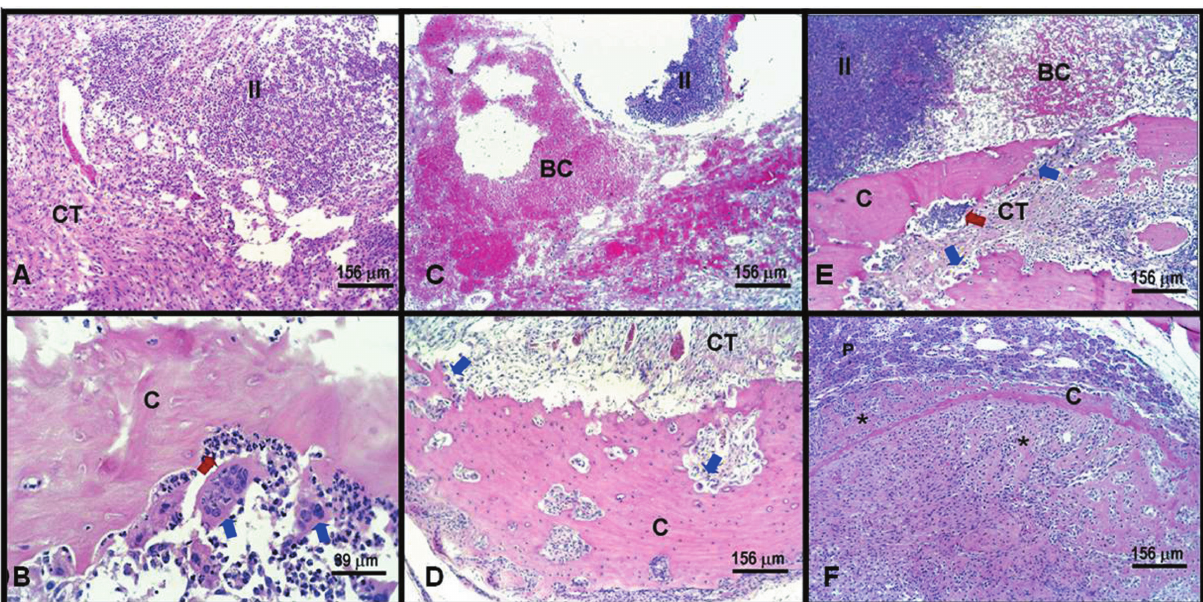
Figure 4- Experimentally induced alveolitis result in delayed alveolar healing. Histological longitudinal specimens of Group II: 6 days postoperative (A and B) showing inflammatory infiltrate with an exuberant presence of bacteria (II) surrounded by connective tissue (CT) occupying the cervical portion of socket (A); neutrophilic infiltrate predominant (red arrows), osteoclasts (blue arrows) resorbing buccal cortical plate in median portion of socket (B); 15 days postoperative (C and D) showing inflammatory infiltrate (II) and blood clot (BC) in (C); buccal cortical plate resorption (blue arrows) surrounded by connective tissue (CT) in (D); 28 days postoperative (E and F) displaying buccal cortical plate resorption (blue arrows), persistent inflammatory infiltrate and blood clot (BC) remains in median third of socket (E); modest bone trabeculae (asterisk) attached to apical cortical plate (C) in apical third of socket (F).